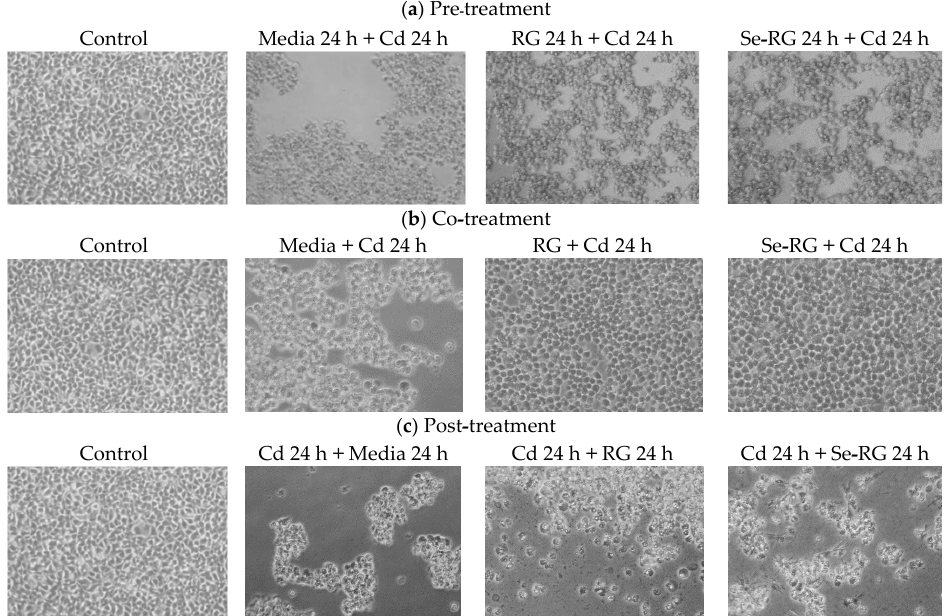
Figure 4. Morphology of cells of HEK293 kidney cells while incubated the cells with RG/Se-RG and CdCl 2 at different time order of treating the extracts ( a ) pre - incubation ( b ) co - incubation and ( c ) post - and CdCl 2 at different time order of treating the extracts ( a ) pre-incubation ( b ) co-incubation and ( c ) incubation. C means control; Cd means CdCl 2 at CC 50 level (68.50 µg/mL). post-incubation. C means control; Cd means CdCl 2 at CC 50 level (68.50 µ